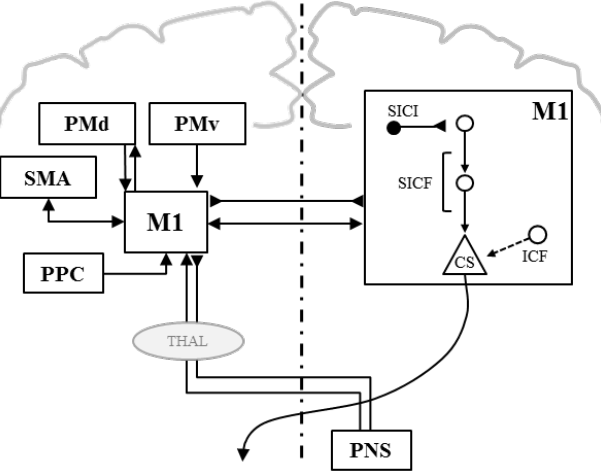
Figure 2. The nature of interregional and interhemispheric connectivity with M1 (left brain) and intracortical connections in M1 (right brain) for hand muscles. M1: primary motor cortex; PMd/v: dorsal/ventral premotor cortex; SMA: supplementary motor area; PPC: parietal posterior cortex; THAL: thalamus; PNS: peripheral nervous system: SICI: short-interval intracortical inhibition; SICF: short-interval intracortical facilitation; arrow: excitatory influence; inverted triangle: inhibitory influence. Adapted with permission from Reis et al. [49].